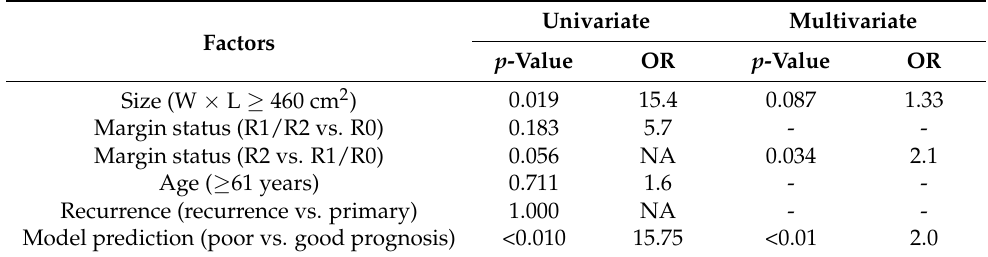
Table 2. Multivariate comparison of model prediction and clinical factors. W = width, L = length, R2 = gross positive margin, R1 = microscopically positive margin, R0 = negative margin. Univariate Multivariate Factors p -Value OR p -Value OR Size (W × L ≥ 460 cm 2 ) 0.019 15.4 0.087 1.33 Margin status (R1/R2 vs. R0) 0.183 5.7 - - Margin status (R2 vs. R1/R0) 0.056 NA 0.034 2.1 Age ( ≥ 61 years) 0.711 1.6 - - Recurrence (recurrence vs. primary) 1.000 NA - - Model prediction (poor vs. good prognosis) <0.010 15.75 <0.01